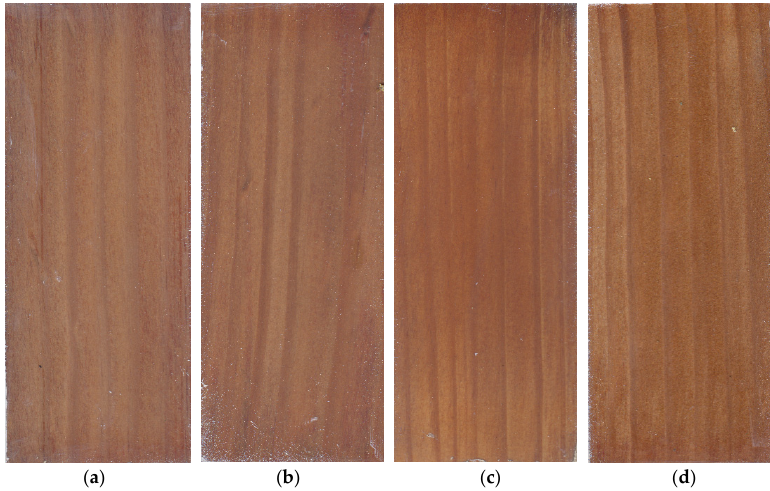
Figure 8. Appearance of clear coatings on PF resin treated radiata pine panels exposed to the weather for 4 years: ( a ) acrylic/30% PF; ( b ) alkyd/30% PF; ( c ) solvent ‐ based spar/30% PF ‐ HALS; ( d ) water ‐ based spar urethane/30% PF ‐ HALS.